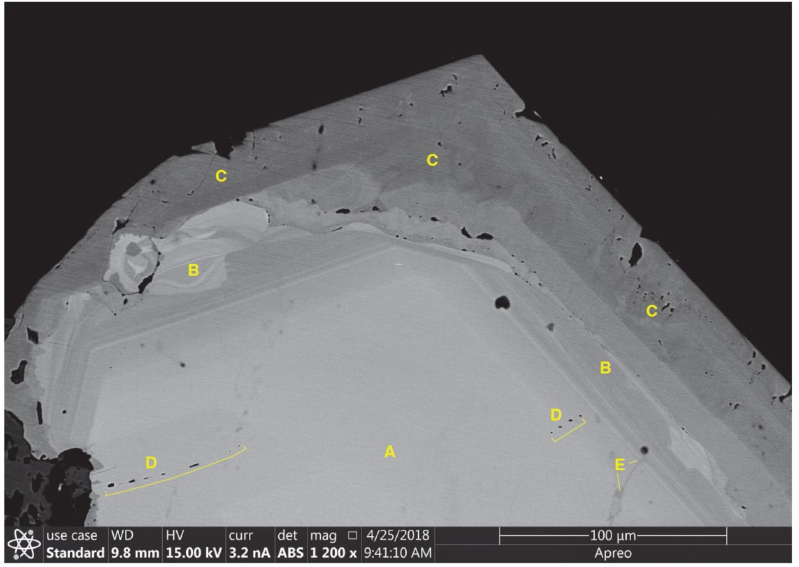
Figure 28. Blow-up of part of the titanite crystal shown in Figure 27. (A) Bright core zone with Fe/Al ~ 1:1 and high LREE. (B) Wavy zone with Fe/Al still about 1:1, but more variable LREE trending to lower values (and brightness). (C) Euhedral rim zone with many fluid inclusions, high Al and F, and low Fe and LREE. Annealed cracks terminating at the boundary between the core and wavy zones now represented by fluid inclusion trails (D) or by cracks with a secondary titanite that has lower LREE